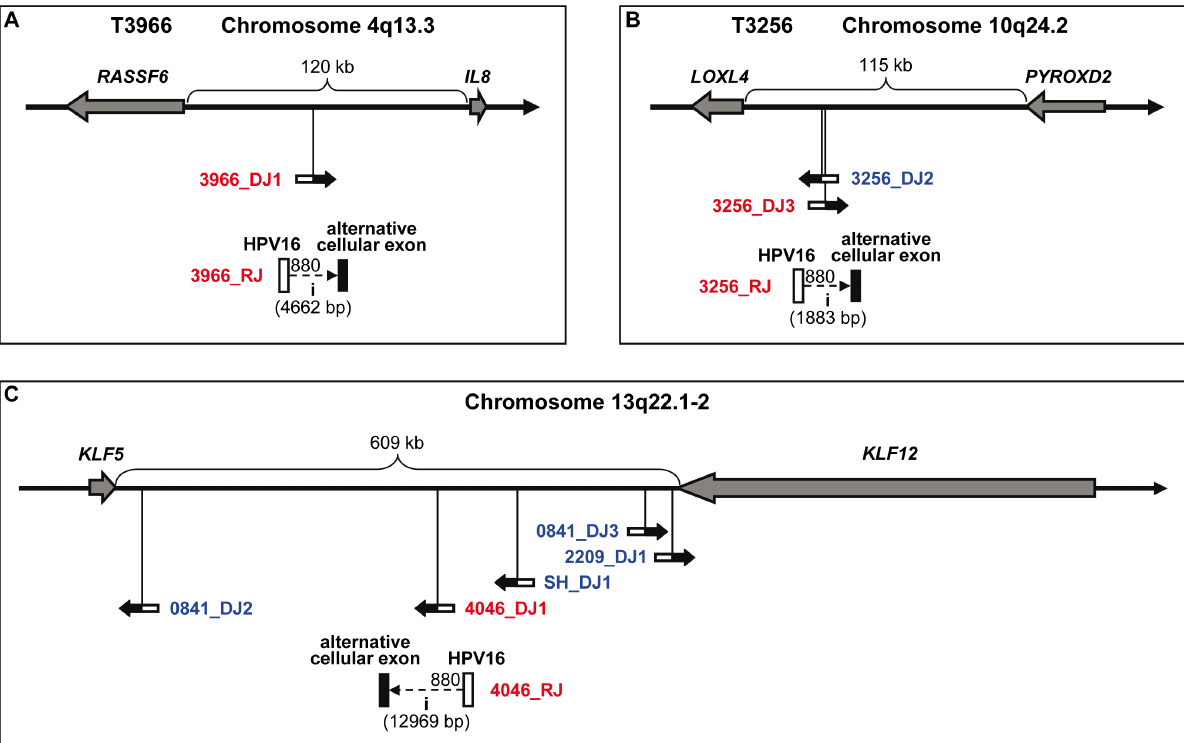
Figure 5. Examples of intergenic HPV16 DNA integration sites. (A) Tumor T3966 has one transcriptionally active HPV16 integration site 3966_DJ1 (TA-group 1), which is located between the cellular genes RASSF6 and IL8 , and has the same orientation as the downstream gene IL8 . In the fusion transcript 3966_RJ, the viral exon is spliced to an intergenic alternative cellular exon. (B) Tumor T3256 (TA-group 2) has three HPV16 integration sites, one (3256_DJ1) on chromosome 3 (not shown) and two (DJ2 and DJ3) on chromosome 10q24.2 between the cellular genes LOXL4 and PYROXD2. Only 3256_DJ3 is transcribed. The fusion transcript 3256_RJ is in opposite orientation to the downstream gene PYROXD2 . (C) In the chromosome region 13q22.1-2, five HPV16 integration sites identified in four independent DNA samples are located in the large intergenic region between the cellular genes KLF5 and KLF12 . Only one integrated HPV16 DNA (4046_DJ1) is transcribed.